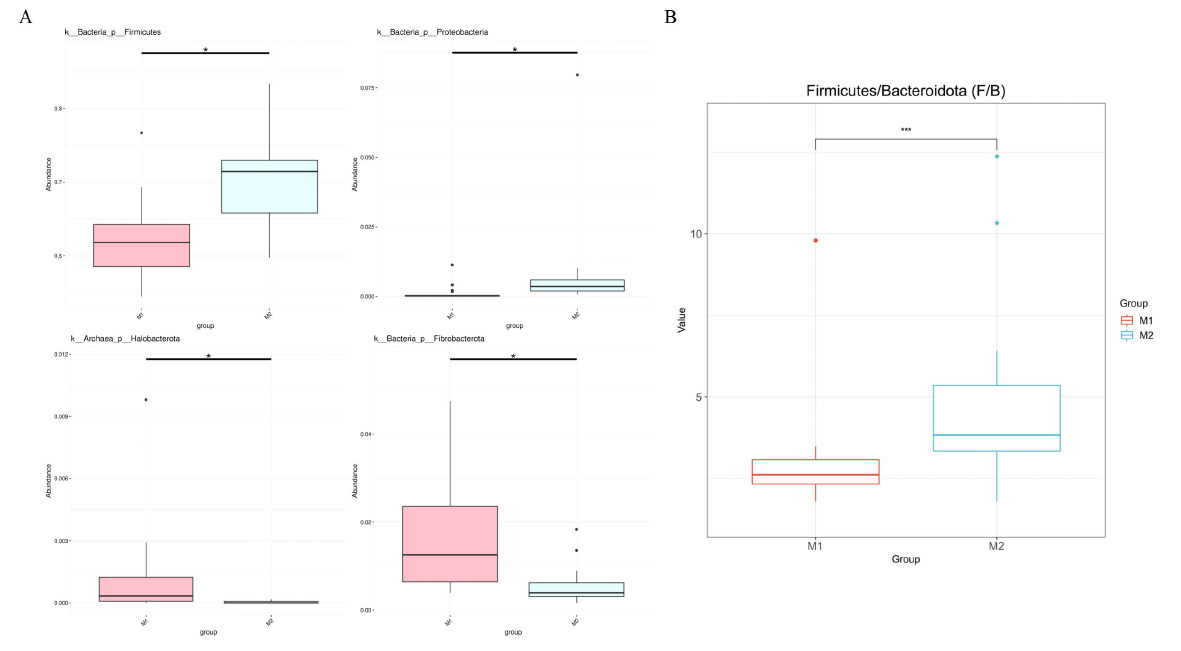
Figure 4. Dfferences in microbes at cecal phylum level in Hu sheep with different BMI. * means p < 0.05, *** means p < 0.001. ( A ) Phylum level; ( B ) difference in ratio of Firmicutes to Bacteroidetes . At the genus level (Table 4), 12 bacterial genera such as Saccharofermentans , Prevotella